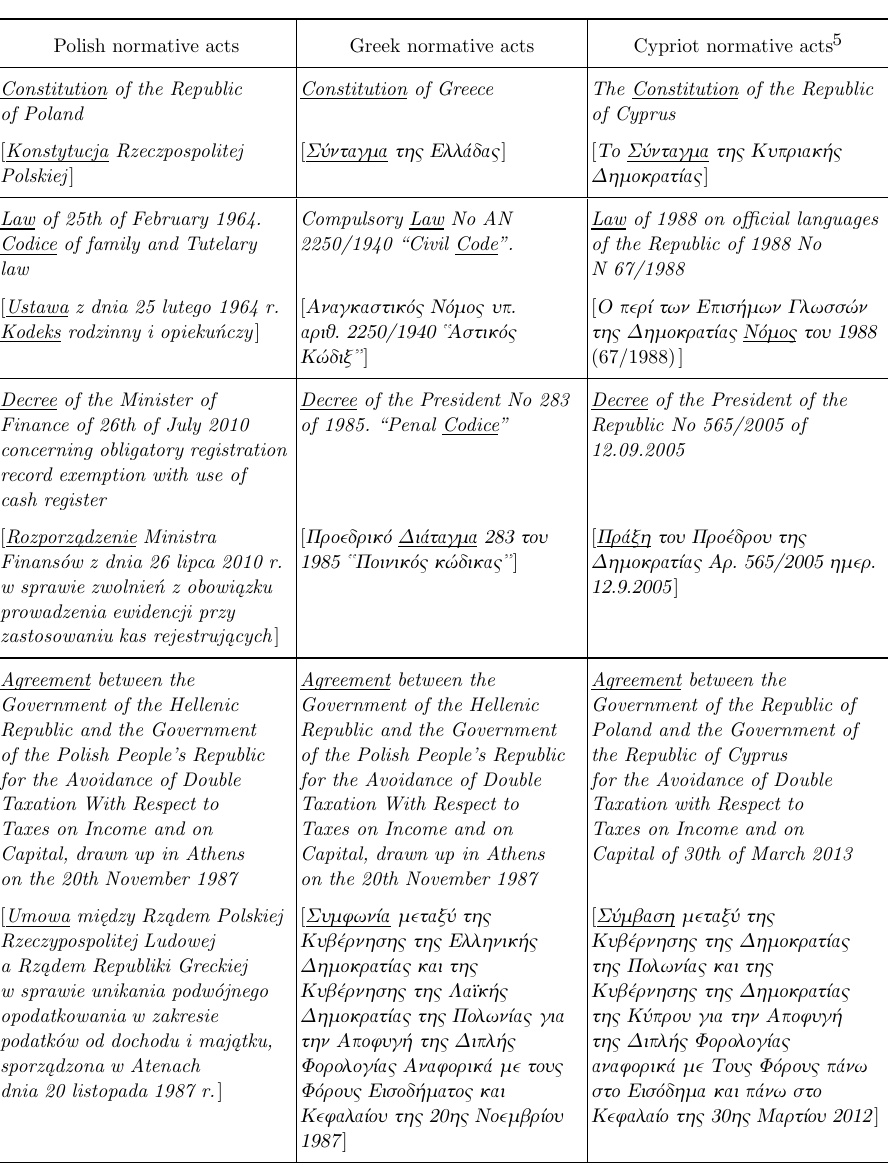
Exemplary titles of normative